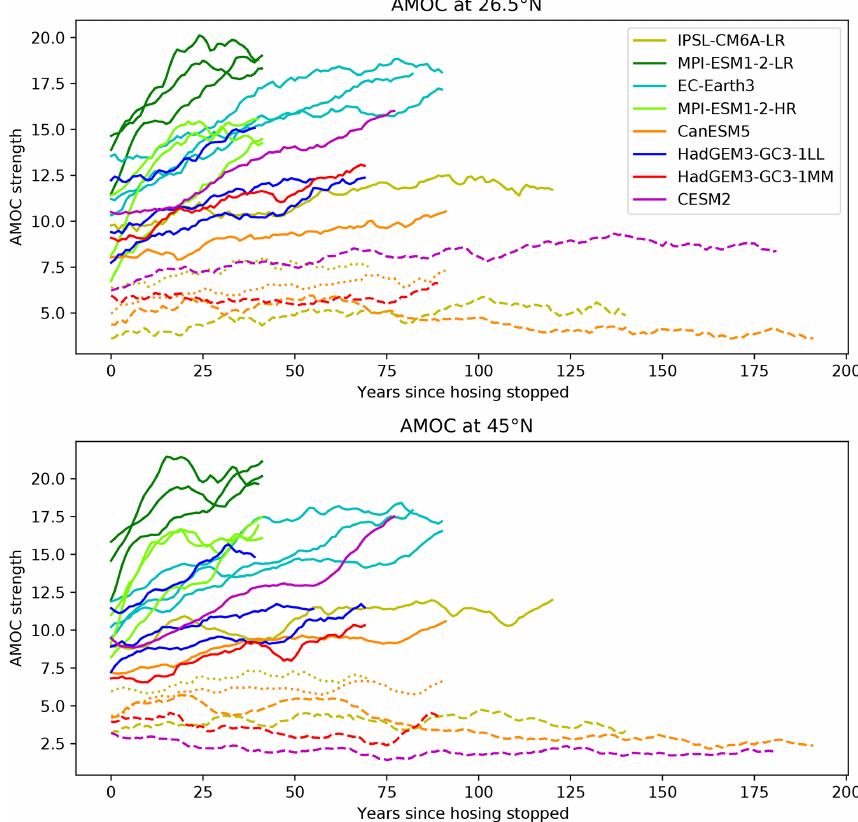
Figure 6. AMOC time series in recovery experiments plotted as 10-year running means. All recovery experiments in the set have experienced UH of 0.3Sv, with plotted time series starting from the time hosing stops. Colours show the model, with solid lines indicating experiments where the AMOC recovers, dashed lines indicating experiments where the AMOC stays in a weak state, and dotted lines indicating experi- ments where the AMOC response is uncertain. The top panel shows the AMOC measured at 26.5 ◦ N, and the bottom panel shows the AMOC at 45 ◦ N (maximum in depth).